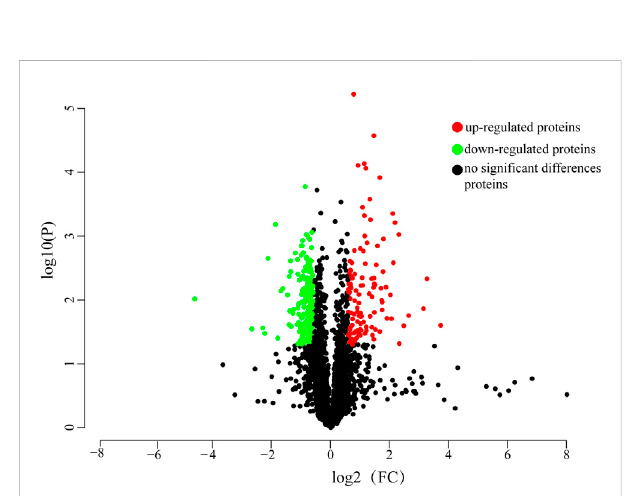
FIGURE 2 Volcano plot of differentially expressed proteins. Green dots represent downregulated proteins, red dots represent upregulated proteins, black dots represent genes with no signi fi cant differences in